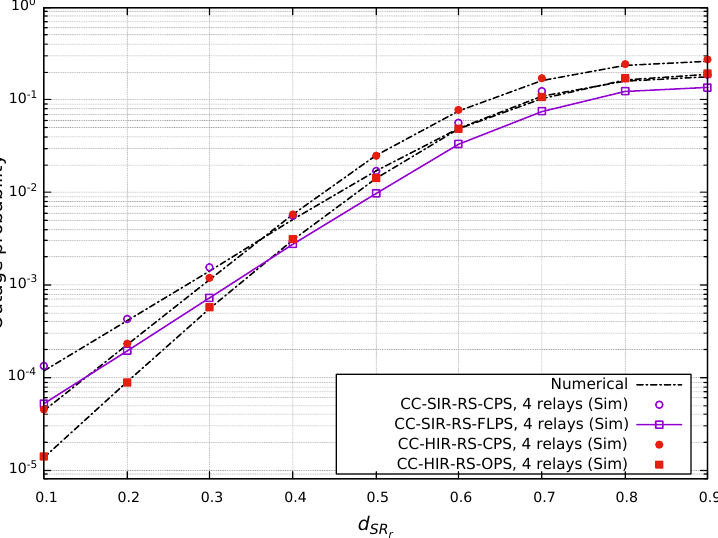
Figure 9. Numerical and simulated outage probability results of the CC-HIR-RS and CC-SIR- RS schemes when varying d SR in the interval [ 0.1, 0.9 ] , four relays, E b / N 0 = 10 dB, and r R = 0.5